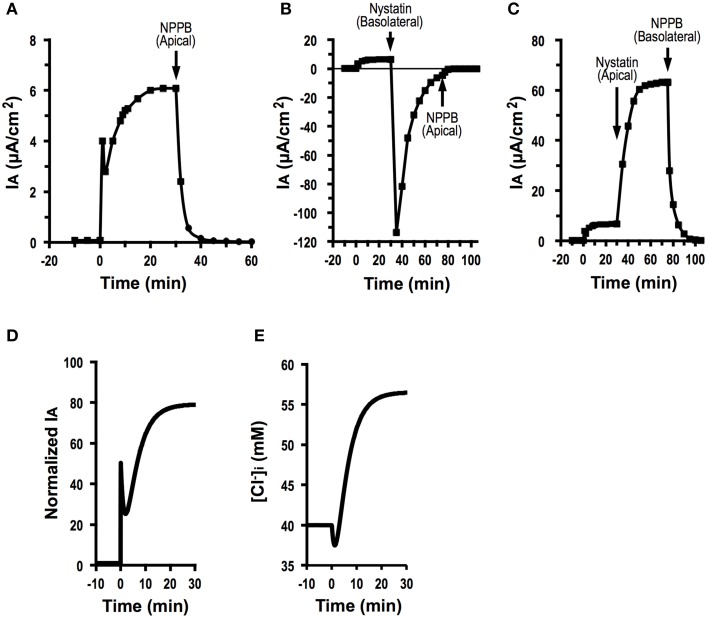
Forskolin action on Cl− secretion (IA), apical conductance (GA) and basolateral Cl− conductance (GB) under an assumption with no change in membrane potential (V = V0), and simulation of Cl− secretion (IA) and [Cl-]i. (A) The effect of foskolin on Cl− secretion (IA). Forskolin (10 μM) applied to the apical and basolateral solutions at time = 0 min induced an initial, transient increase in Cl− secretion (IA (0)) followed by a decrease. After reaching its minimum level, Cl− secretion (IA) again increased toward a steady value. After Cl− secretion (IA) reached a steady value, we applied 100 μM NPPB to the apical solution at time = 30 min, which diminished Cl− secretion (IA). (B) Apical Cl− conductance (GA) of A6 cells treated with forskolin. After application of forskolin (10 μM) at time = 0 min, we added nystatin (50 μM) to the basolateral solution to permeabilize the basolateral membrane at time = 30 min. Then, we applied 100 μM NPPB to the apical solution at time at 75 min. Under this condition, we determined the NPPB-sensitive conductance of apical membrane. (C) Basolateral Cl− conductance (GB) of A6 cells treated with forskolin. After application of forskolin (10 μM) at time = 0 min, we added nystatin (50 μM) to the apical solution to permeabilize the apical membrane at time = 30 min. Then, we applied 100 μM NPPB to the basolateral solution at time 75 min. Under this condition, we determined the NPPB-sensitive conductance of basoalteral membrane. (D) Simulated Cl− secretion (IA) of A6 cells treated with forskolin. A stimulant is applied at time = 0 min. We obtained IA(0)=50 IA0, IA(∞)=79 IA0, GA=50 GA0 and GB = 1.33 GB0 from this simulation [Equation (A18)]. (E) Simulated [Cl-]i of cells secreting Cl− shown in (D). A stimulant is applied at time = 0 min. [Cl-]i transiently decreases after application of forskolin followed by a gradual increase.